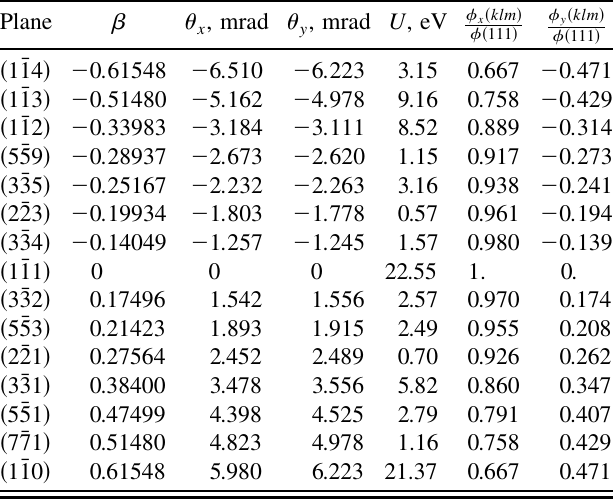
TABLE I. Characteristics of crystallographic planes. Plane